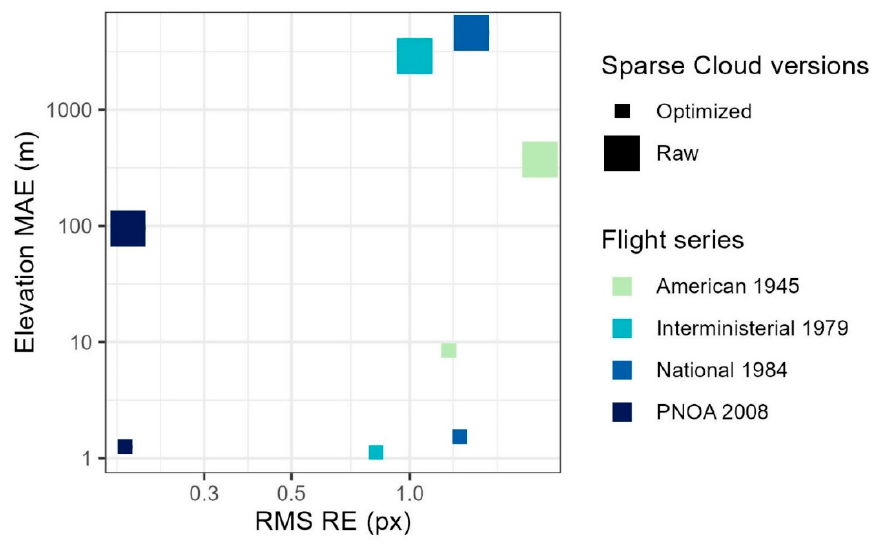
Figure 6. Improvement of the Optimized Sparse Cloud in SfM: elevation MAE vs. RMS RE.